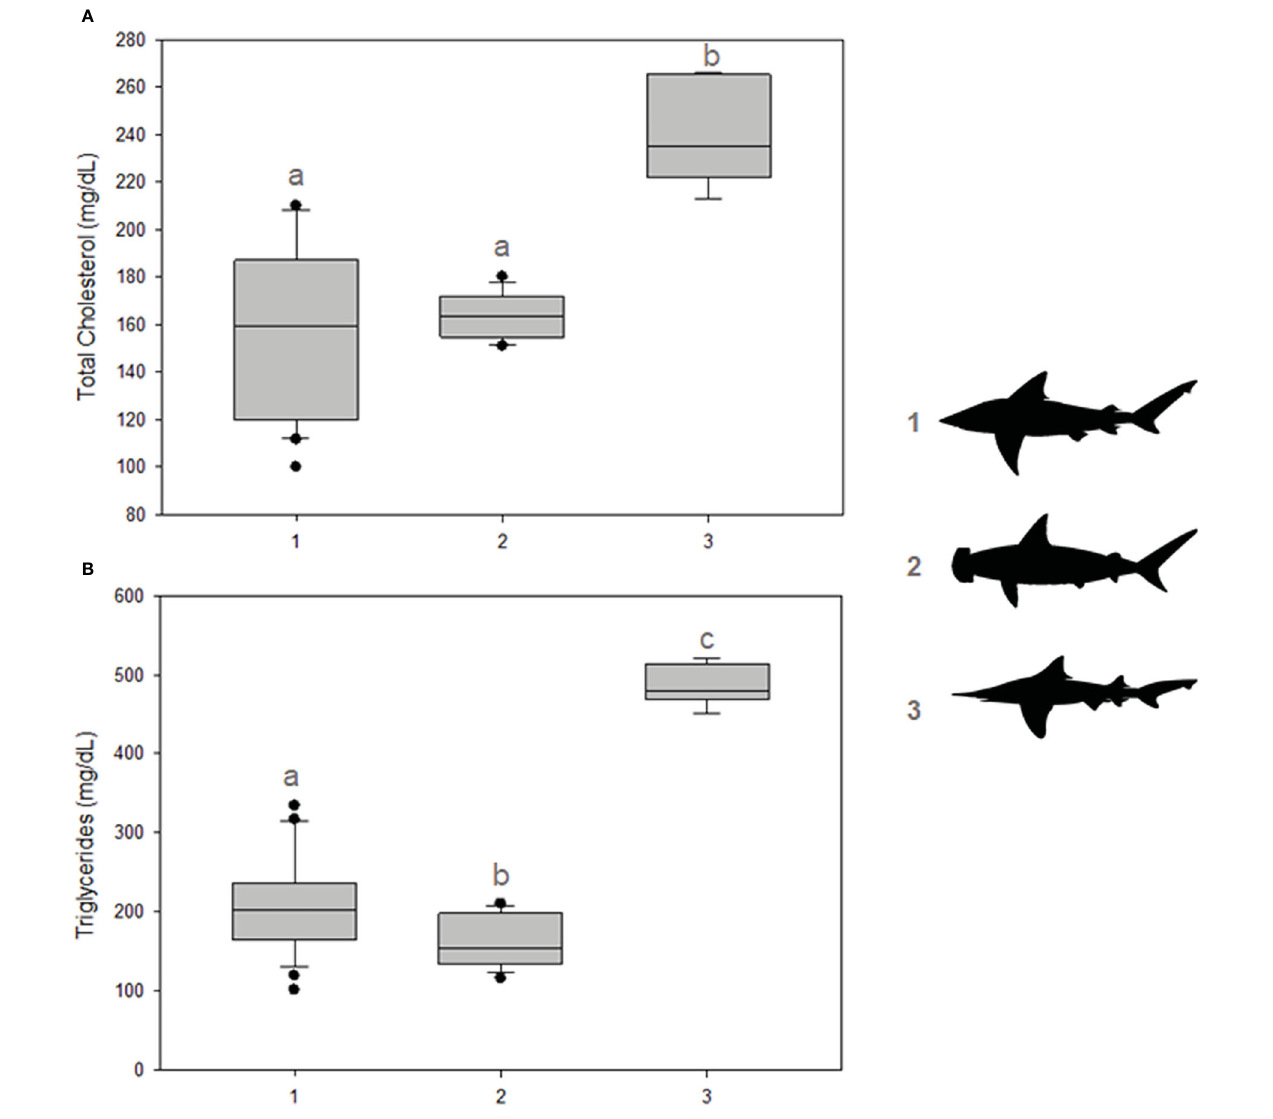
FIGURE 3 Energy metabolism indicators. (A) Total cholesterol concentrations; (B) Triglyceride concentrations. The shark groups are indicated in the graph by 1) Carcharhinus spp., 2) Sphyrna spp., and 3) I oxyrhynchus . Statistical differences are represented by lowercase